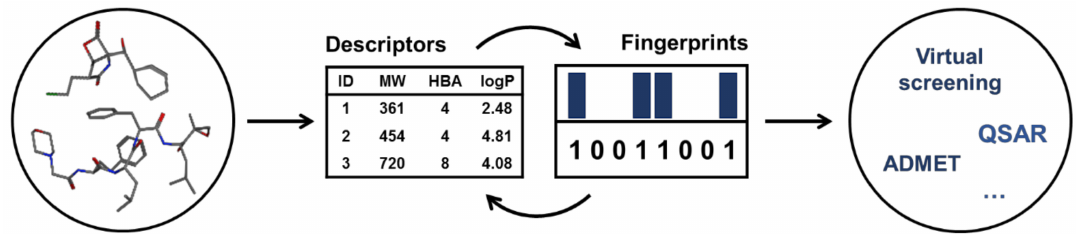
Figure 1. Molecular descriptors and fingerprints are examples of strategies that allow researchers to extract important information about compounds that can be used in additional computer-aided drug design techniques, such as virtual screening, quantitative-structure-activity relationship (QSAR) and prediction of absorption, distribution, metabolism and excretion-toxicity (ADMET)